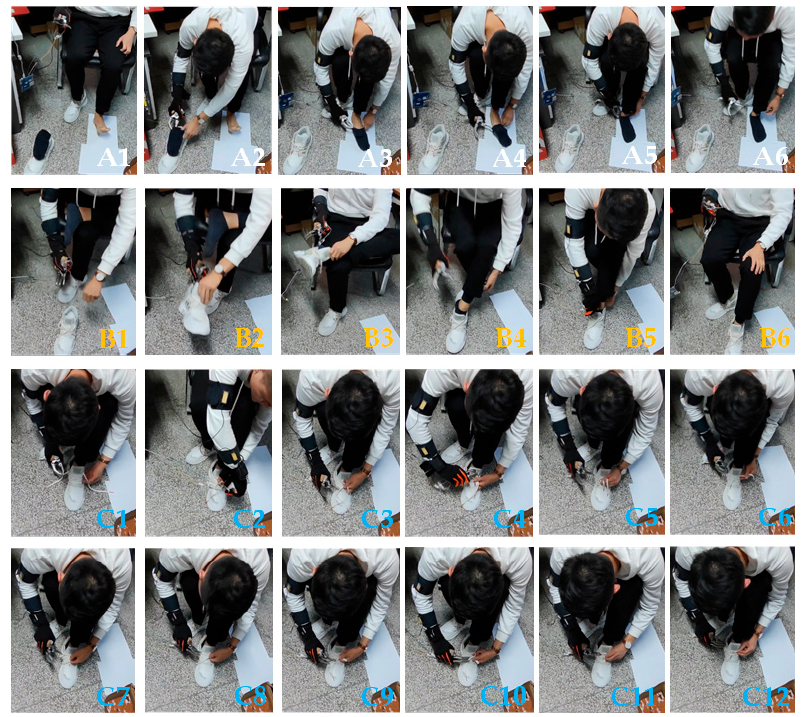
Figure 9. Demonstration of the three actions. Table 6. Delay time generated by two control methods.